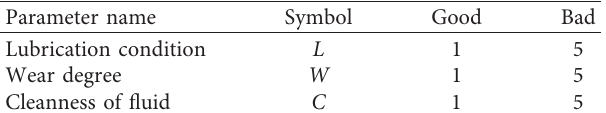
Table 1: Rating scales for unquantifiable working condition